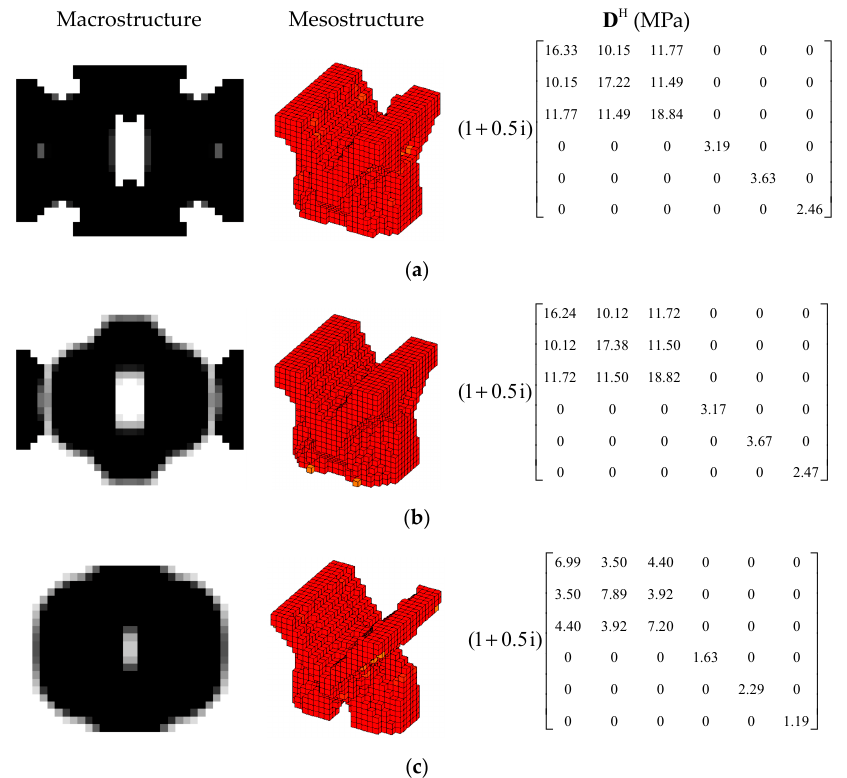
Figure 16. Design results for maximizing the second modal loss factor: ( a ) Case 4: V MA